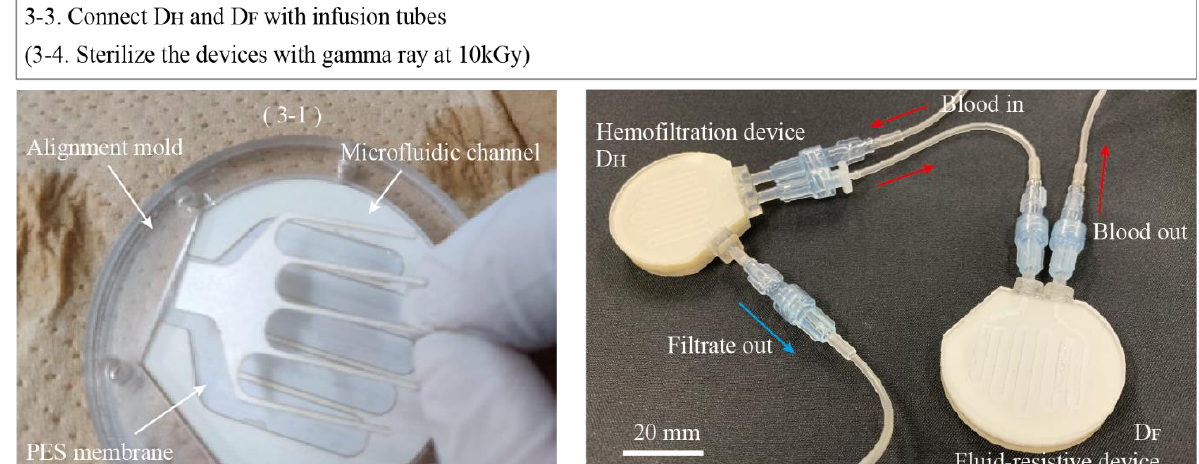
Figure 4. Fabrication process of the hemofiltration device and the fluid-resistive device. Microfluidic channels with adhesives are laser cut to have two patterns, as shown in the Step 1. PES membranes are formed by the liquid inversion method (Step 2). The devices are formed by bonding the channels and PES membranes alternatively, where they are aligned with a jig. PES membranes are known to be asymmetric and have nanopores on one side and micropores on the other side. Note that the blood (or sample) channels contact with nanoporous side of the membrane.